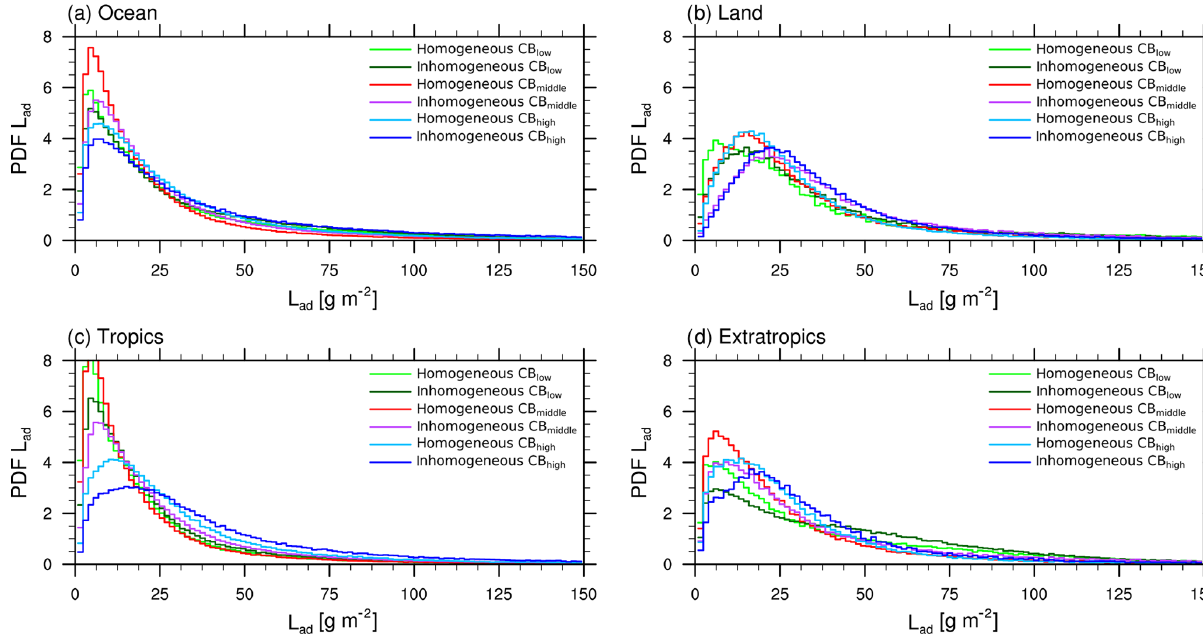
Figure A2. As Fig. 4b, but separately for (a) ocean, (b) land, (c) the tropics (20 ◦ S–20 ◦ N) and (d) the extratropics (40–60 ◦ S and 40–60 ◦ N).